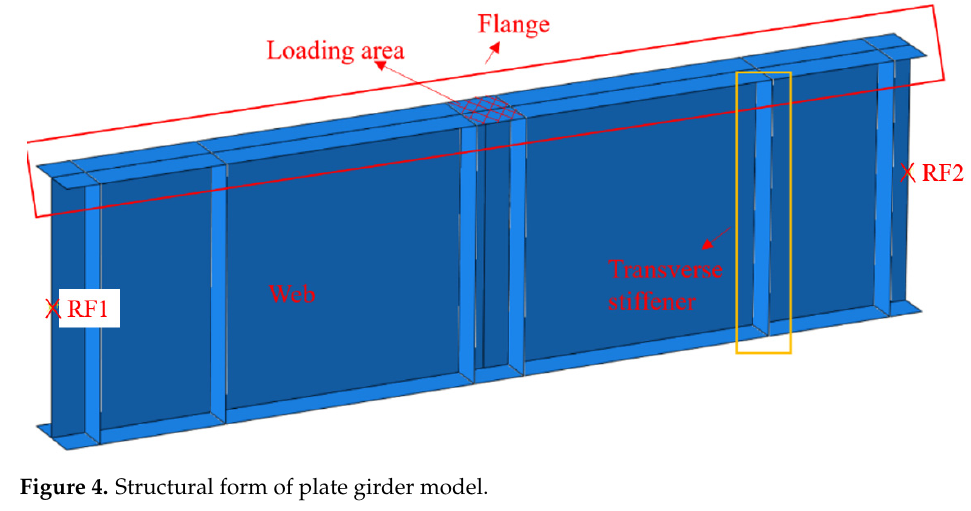
Figure 4. Structural form of plate girder model.